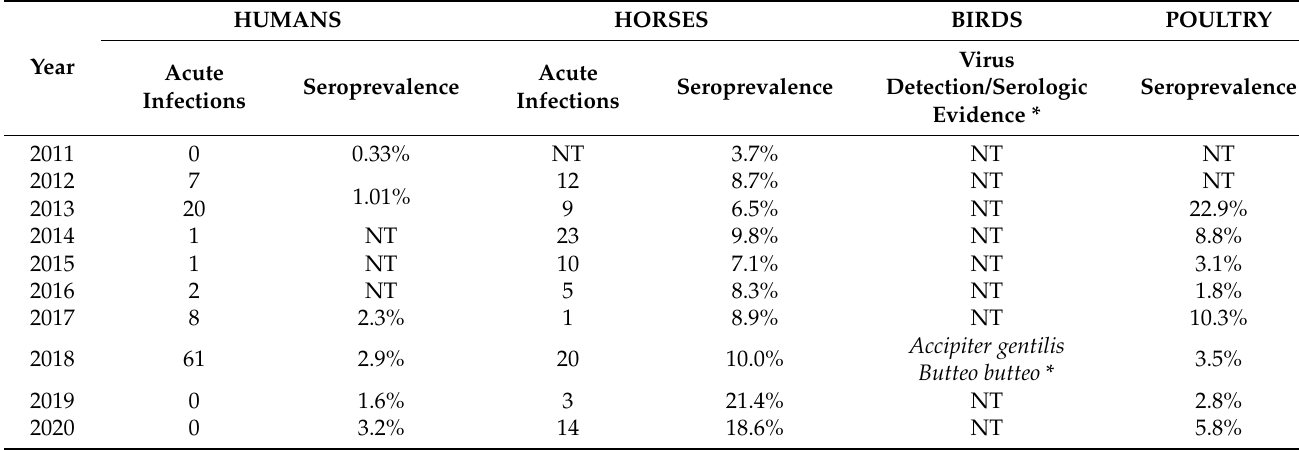
Table 1. WNV infections in Croatia detected in humans and sentinel animals,